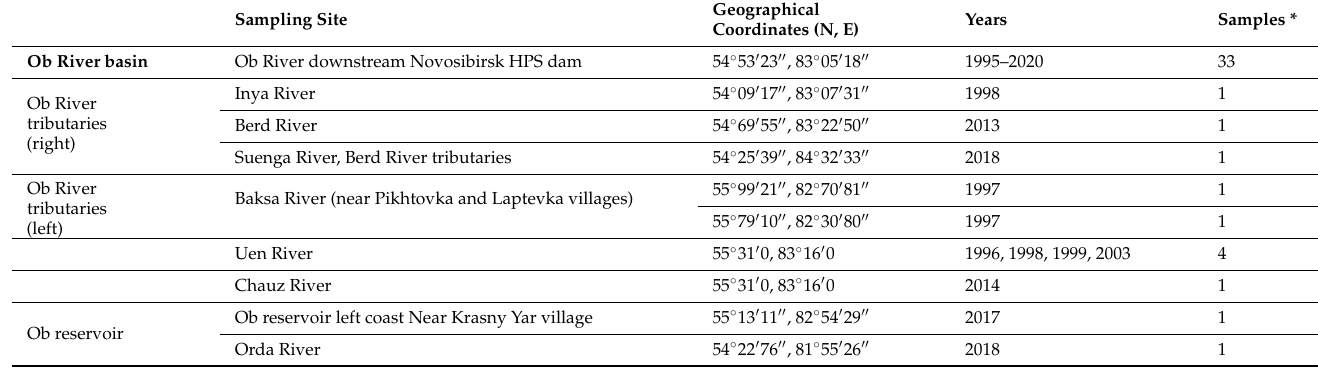
downstream Sorochikha village (31); Kuria River (32); Burla River (33); Lake Krotovo (34). Table 1. Sampling-site bithyniid snails in water bodies of the Novosibirsk region in 1994–2020. Sampling Site Geographical Coordinates (N, E) Years Samples